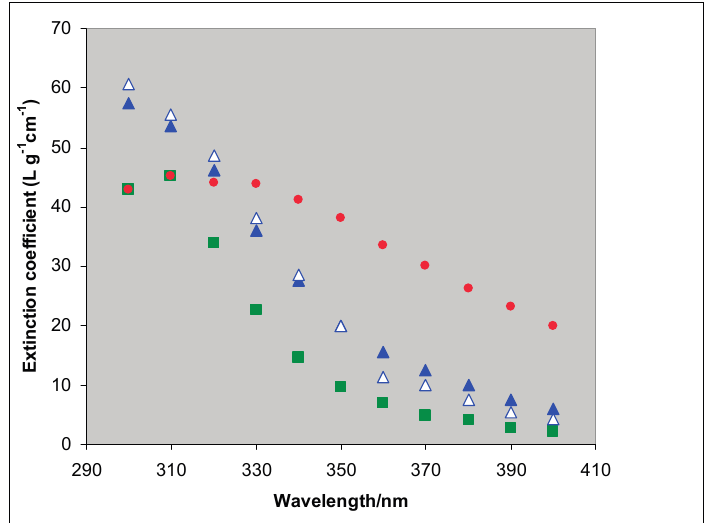
Figure 4. Experimental extinction coefficients for 35 ■ , 50 ▲ and 145 nm ● rutile particles and the calculated coefficients for 50 nm ∆ , derived from Figure